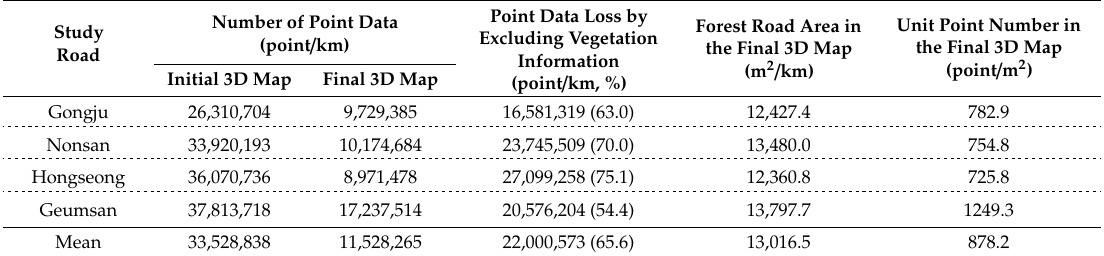
Figure 6. An example of the close range view of the 3D map displaying forest roads using point cloud data obtained from the Mobile Laser Scanner (MLS) survey. The view ( a ) before and ( b ) after removing point cloud data displaying vegetation on the outsides of cut-and-fill slopes. Table 4. Change in the number of point data by excluding vegetation information from the initial 3D maps of the four forest roads